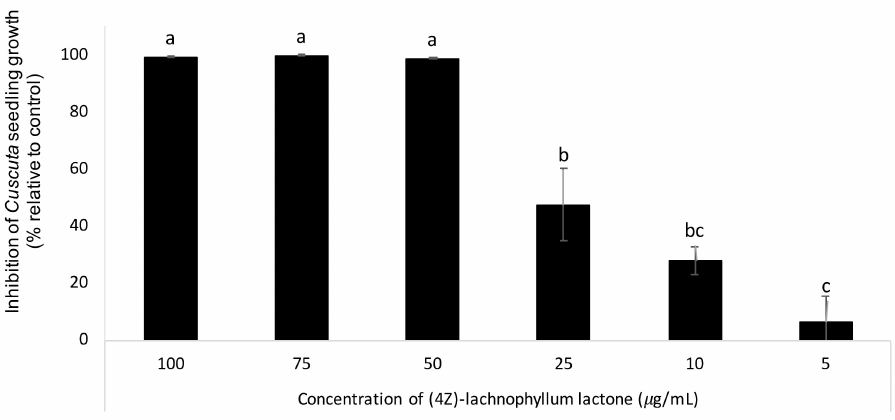
Figure 7. Dose–response screening of the phytotoxic activity on Cuscuta campestris seedling growth of (4 Z )-lachnophyllum lactone. Treatments with different letters are significantly different using the Tukey test ( p = 0.05). Error bars represent the standard error of the